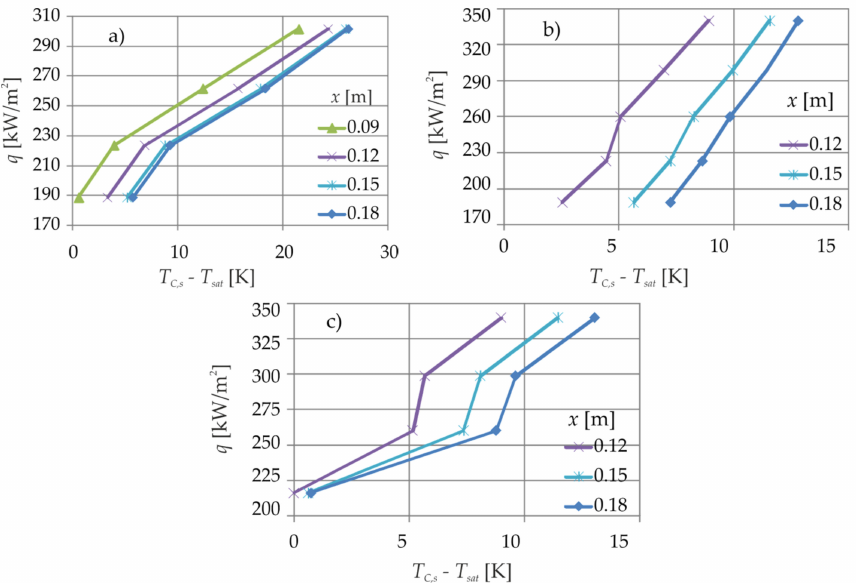
Figure 14. Boiling curves for selected points x along the minichannel length for ( a ) G = 2.2 kg / (m 2 s), ( b ) G = 5.9 kg / (m 2 s) and ( c ) G = 8.6 kg / (m 2 s).